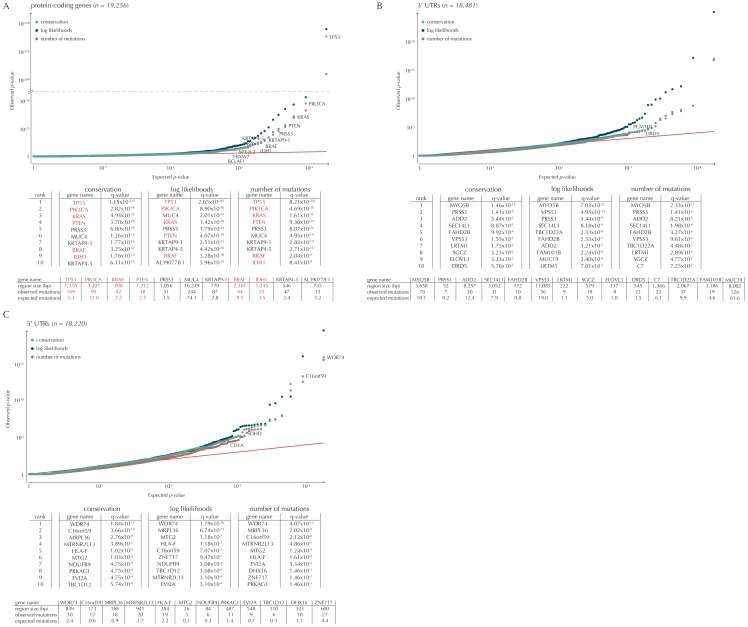
Q-values and top-ten ranking elements for each of the three proposed scoring schemes.Protein-coding COSMIC genes, or non-coding elements associated to COSMIC genes, are highlighted in red. For each element, the region size is given together with the observed number of mutations and the expected number of mutations under the null model. (A) The QQ-plot shows the p-values for all protein-coding genes (n = 19,256) plotted against their uniform expectation under the null. Sixty-four protein-coding genes are found to be significant (conservation scores). (B) QQ-plot of p-values for all 5’ UTRs (n = 18,220). In total, 86 5’ UTRs are significant. (C) QQ-plot of p-values for all 3’ UTRs (n = 18,481), of which 16 are found to be significant. The complete sets of significant elements for each region type are given in Supplementary files 1–3. Similar plots for promoter elements and splice sites are shown in Figure 5.DOI:
http://dx.doi.org/10.7554/eLife.21778.02310.7554/eLife.21778.024Figure 5—figure supplement 1—source data 1.P-values obtained on protein-coding genes, 3’ UTRs and 5’ UTRs using conservation scores.This data set relates to Figure 5—figure supplement 1A–C. P-values obtained using log-likelihoods and number of mutations as scores are in Supplementary files 2–3.